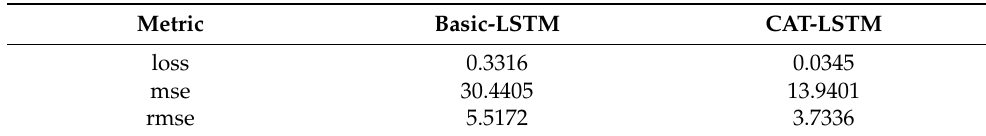
Table 2. Comparison of the results of CAT-LSTM and basic LSTM averaged across all VNFs from SFCs, for the number of RNN units = 80, learning rate = 0.001, the max number of iterations = 800 with early stop, prediction time = 5 s, amount of historical data = 15 s.